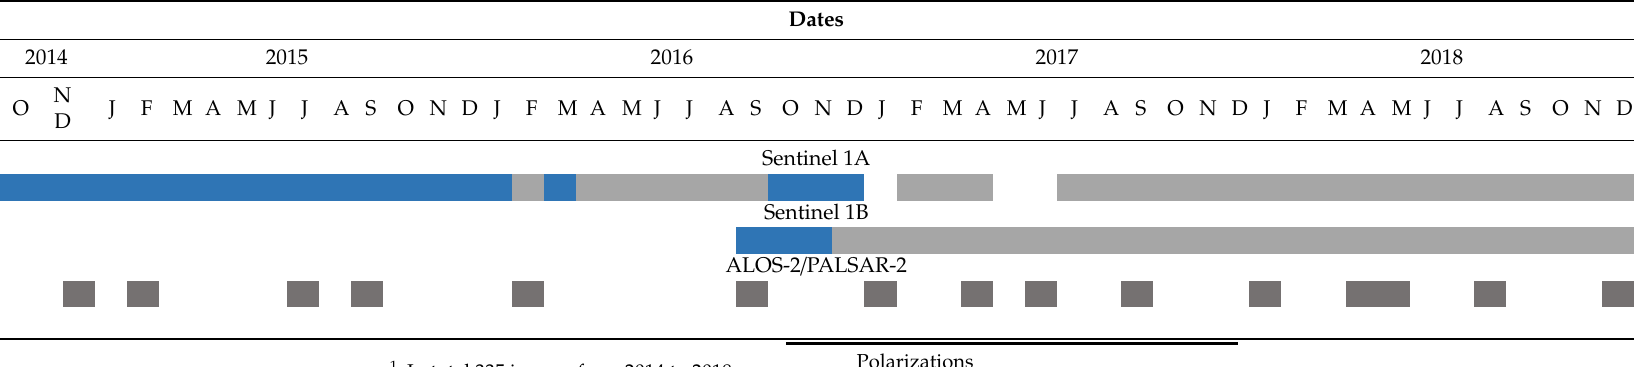
Table 1. Temporal distribution of the Sentinel 1A-1B and ALOS-2 / PALSAR-2 images analyzed 1